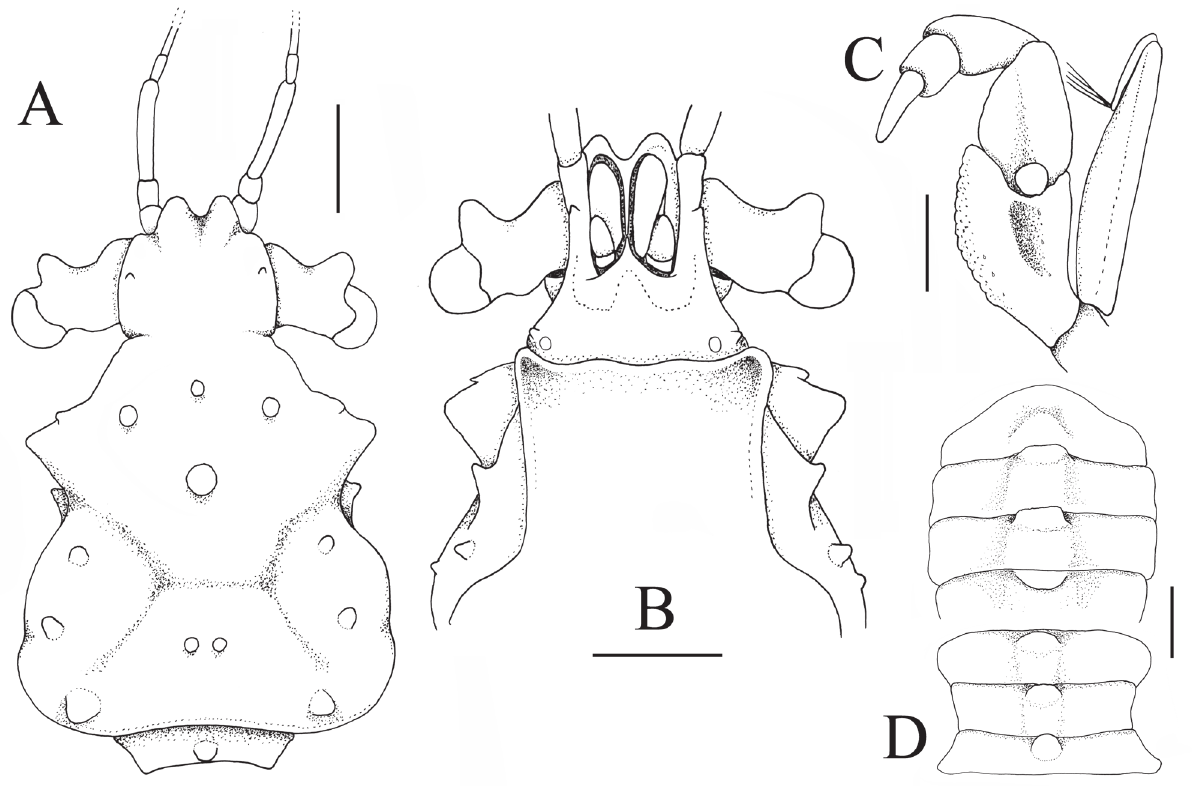
Figure 2. Achaeus umu n. sp., holotype female (1.9 × 2.7 mm) (USNM 1253231), Easter Island. A, dorsal carapace; B, ventral view showing buccal cavity, epistome, antennae, antennules and orbit; C, left third maxilliped; D, female abdomen. Setae not drawn on all structures. Scales: A, B, D = 0.5 mm; C = 0.25